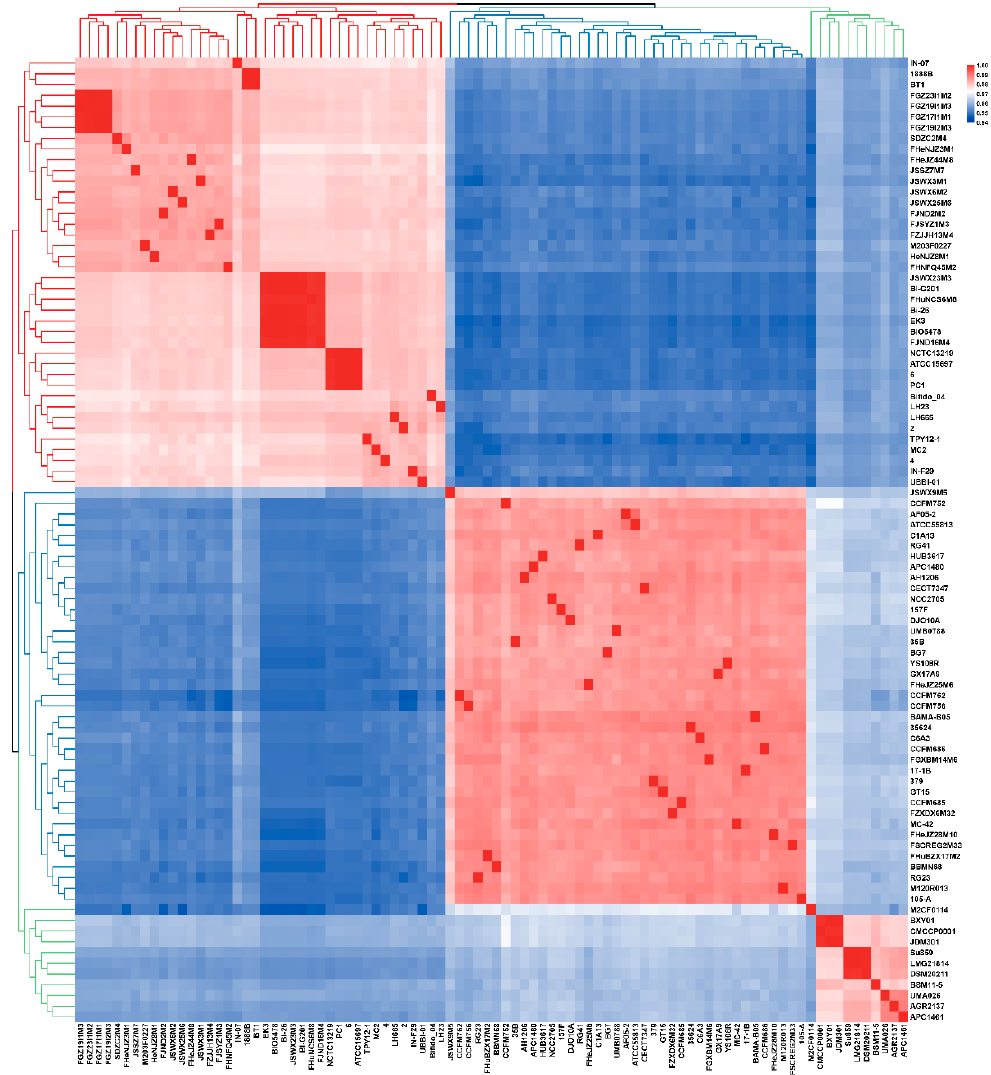
Figure 1. Heatmap based on average nucleotide identity (ANI) of B. longum . The gradation of colour from blue to white to red represents an increasing ANI value. The blue branch represents B. longum subsp. longum , the red branch represents B. longum subsp. infantis and the green branch represents B. longum subsp. suis.